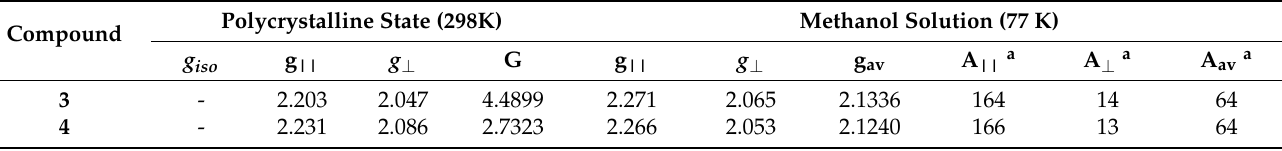
Table 5. EPR spectral assignments of Cu (II) complexes in polycrystalline state at 298 K and solution at 77 K. Polycrystalline State (298K) Methanol Solution (77 Compound